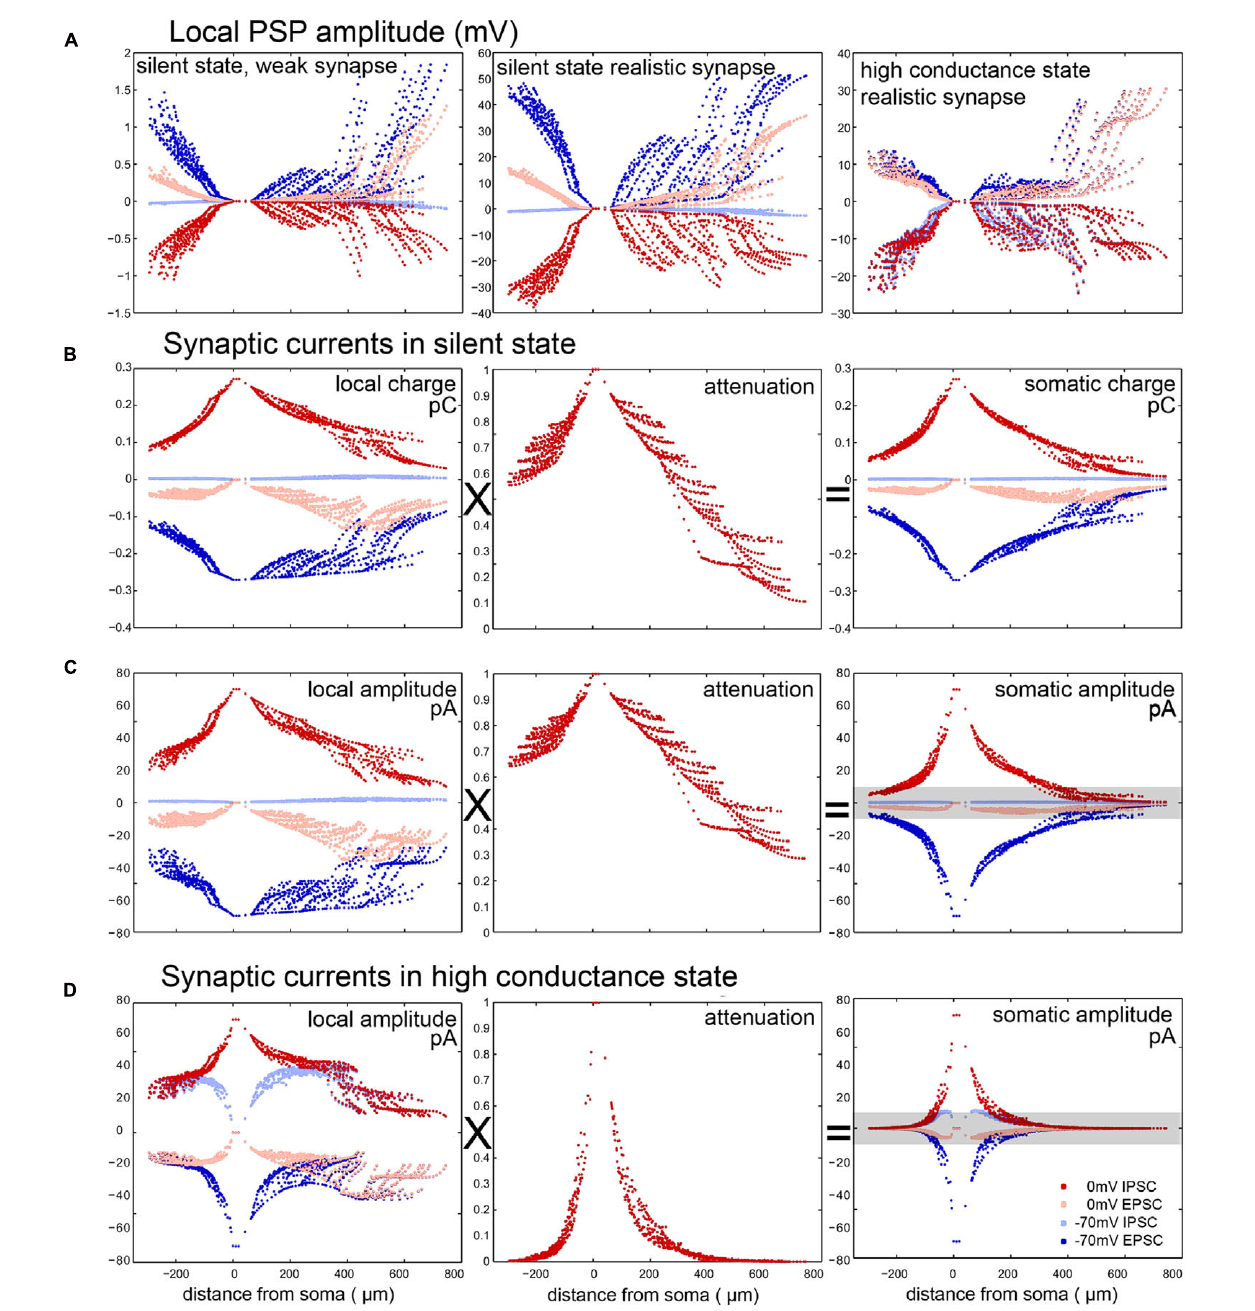
FIGURE 5 | Elements contributing to the error in the somatic measurement of postsynaptic current amplitude and charge in a PC. (A) PSP amplitudes evoked in the SS by a single weak (left, maximal conductance: 10 pS) or a single realistic (center, 1 nS) synapse and by a realistic synapse in the HCS (right). The fact that the figure in the middle is not simply a scaled version of the figure on the left shows the sublinearity due to the effect that the local membrane potential approaches the synaptic reversal potential. In the HCS the input resistance drops, and therefore the voltage change is relatively smaller. (B,C) Somatically recorded PSC amplitudes and charges for single inputs (1 nS) in the SS are the result of the multiplication of local charge/amplitude values with the attenuation of charge/amplitude from the input site to the soma. (D) Somatically recorded PSC amplitudes are calculated similarly in the HCS. Note that here both local values and attenuation show a stronger drop away from the soma, due to high background conductance. Especially in the SS, EPSCs can be recorded with better accuracy (dark blue) and with smaller residual IPSCs (light blue) by clamping the cell to − 70 mV, than IPSCs by clamping the cells to 0 mV (dark red), when there is a large amount of residual EPSCs (light red). This is due to the fact that the reversal potential of excitation is further away from the resting potential than the reversal of inhibition and thus the VC error is bigger when we try to measure IPSCs at 0 mV. Gray bar in (C) and (D) show those events that are below a specific PSC detection threshold (10